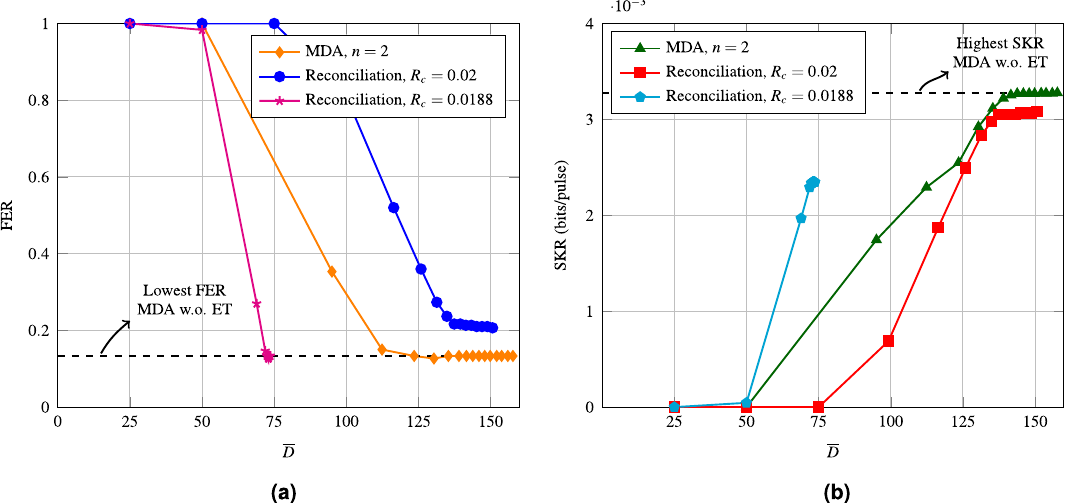
Figure 5. ( a ) FER of MDA compared to an LDPC code with R c = 0.02, and to an LDPC code with R c = 0.0188 as a function of the average amount of decoding iterations with ET. All the simulations were performed at an SNR of − 15.23 dB. ( b ) SKR of MDA compared to an LDPC code with R c = 0.02, and to an LDPC code with R c = 0.0188 as a function of the average amount of decoding iterations with ET. All the simulations were performed at an SNR of − 15.23